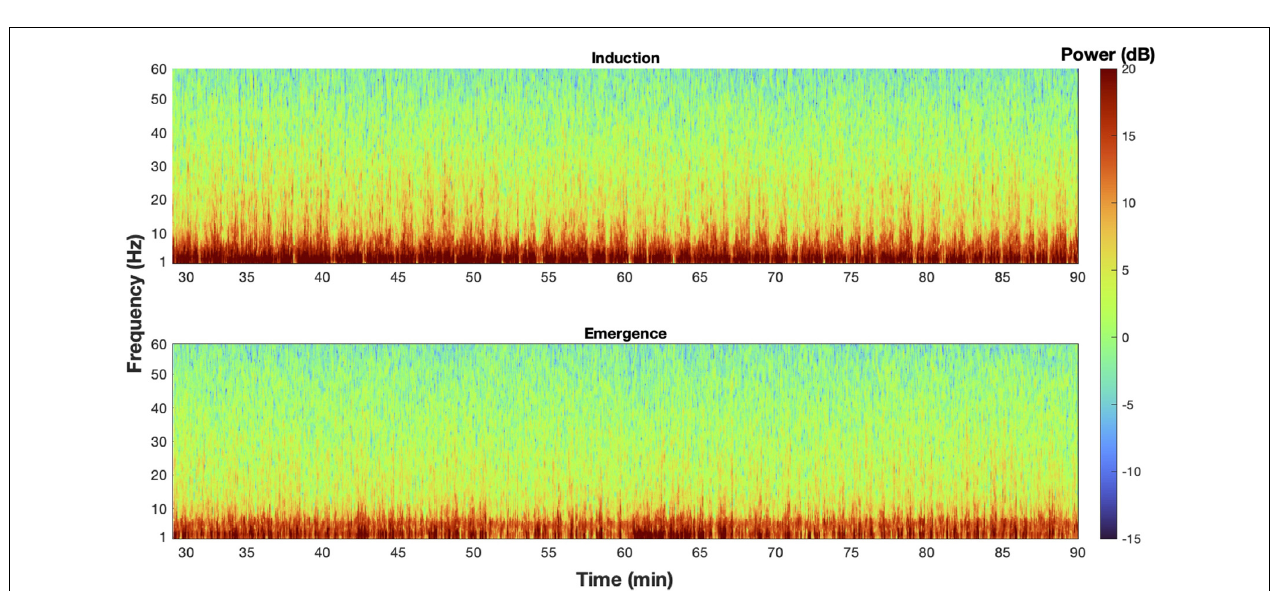
FIGURE 6 | The EEG spectra at steady state is dynamic. An example spectrogram from M2 of mouse 1 during induction (top) and emergence (bottom) exposures that illustrate the dynamic nature of the spectra at steady state, and how taking a mean spectrum erases potentially critical information from the signal.